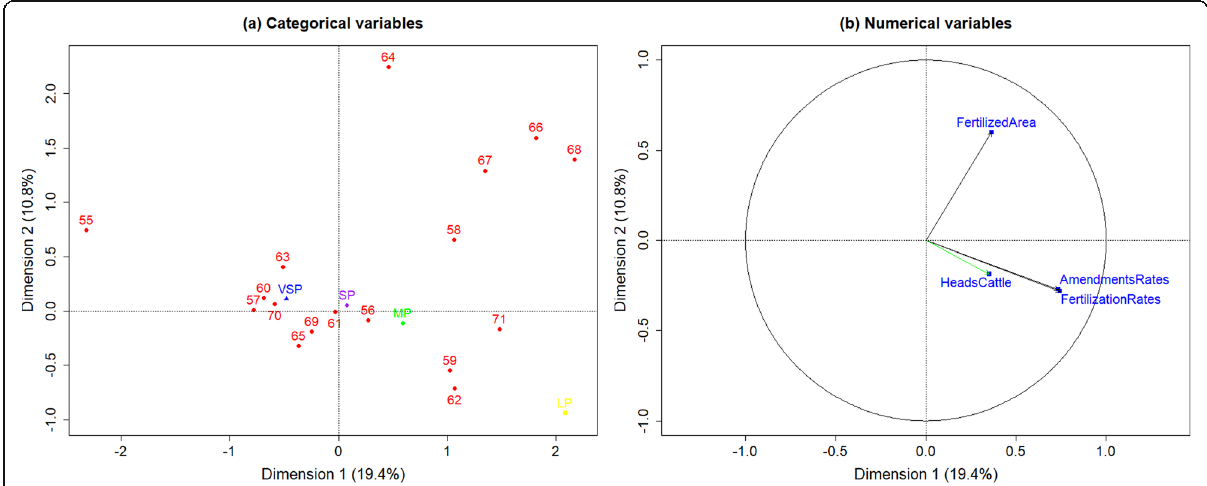
Fig. 4 Spatial projection of a categorical variables and b numerical variables for the component Pasture Management. Coding of categorical